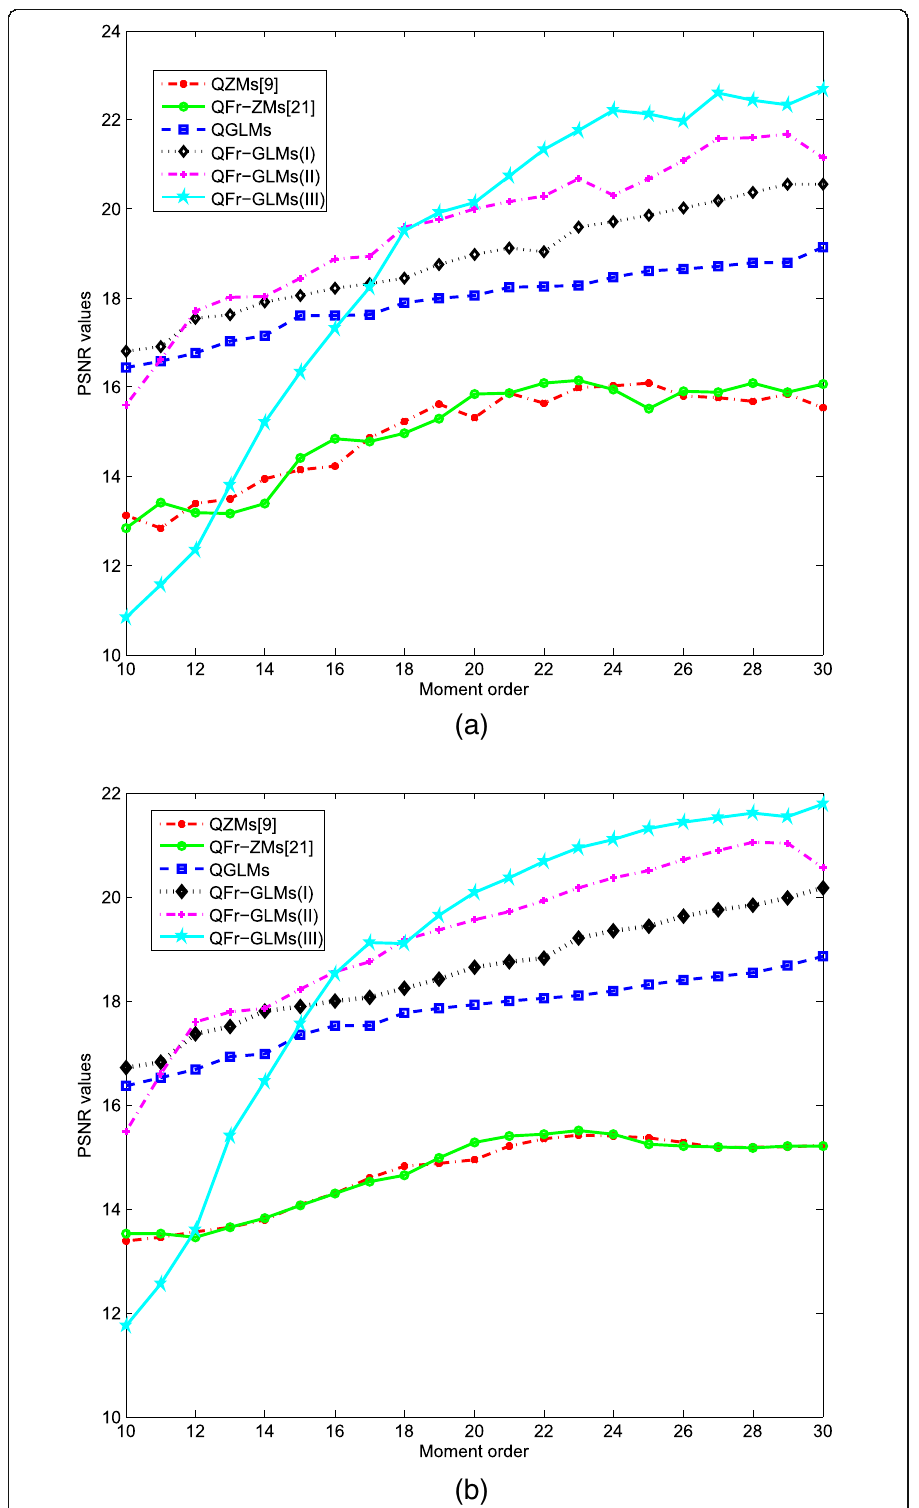
Fig. 6 PSNR versus moment-order curves of different color-image moments after various typesof signal processing: a salt and pepper noise and b smoothing